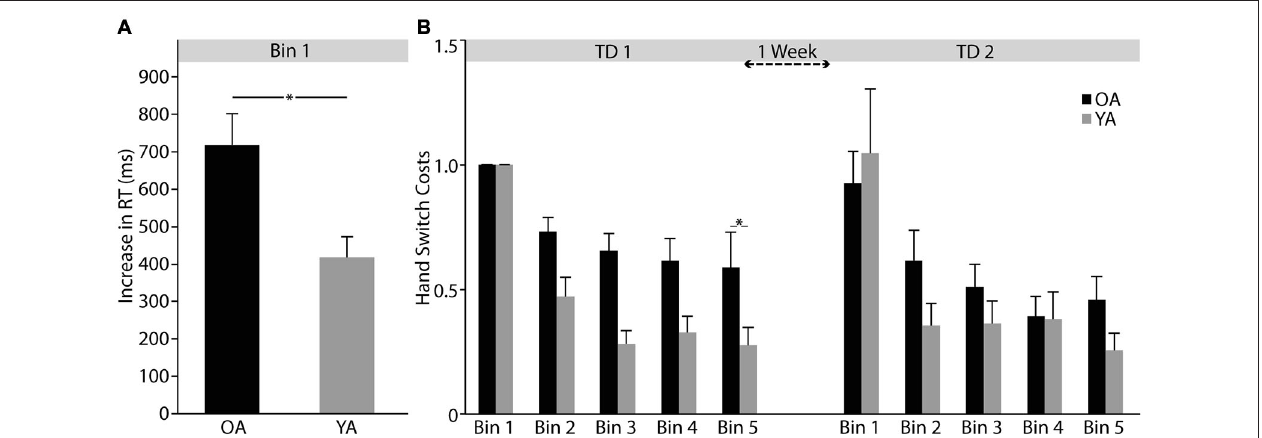
FIGURE 3 | Hand switch costs. (A) Differences in initial hand switch costs (Bin 1) between younger (YA) and older (OA) adults. (B) Learning-related changes in hand switch costs for training day 1 and 2 (TD1 and TD2). For details see text. Response time (RT); One Bin consists of averaged data from six repetitions of the learning sequence. Error bars represent mean ± standard error of the mean, ∗ p <